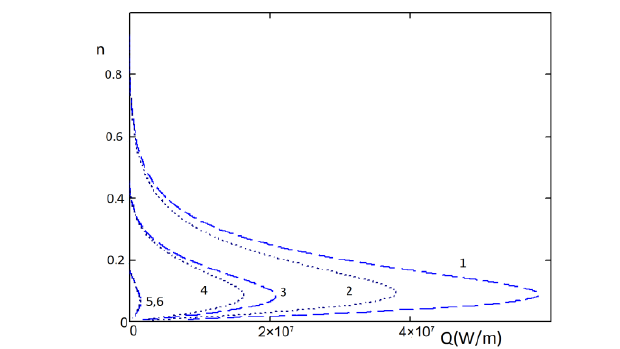
Figure 4. The NLSP propagation constant n vs. the NLSP total energy flux Q. The saturation level is